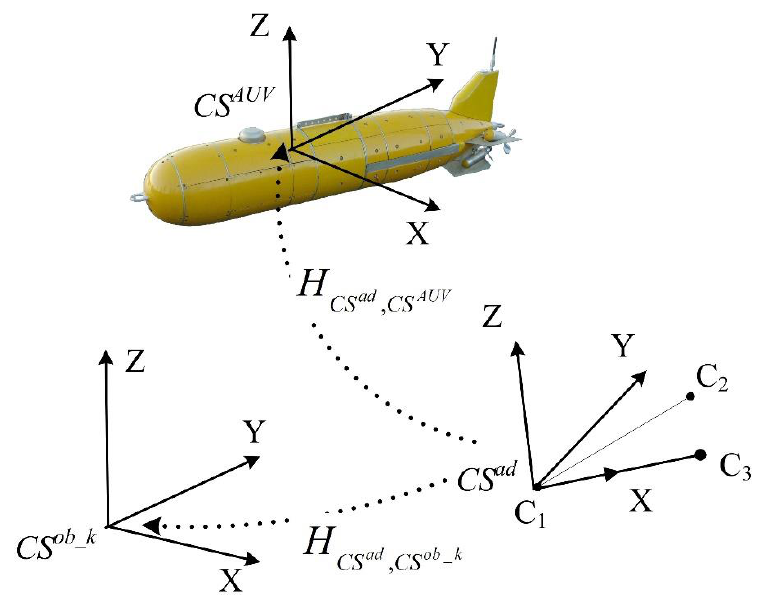
Figure 5. Calculation of the geometric transformation matrix from the AUV CS ( CS AUV ) to the CS of the SPS object ( CS ob_k ) using the auxiliary CS ( CS ad ).